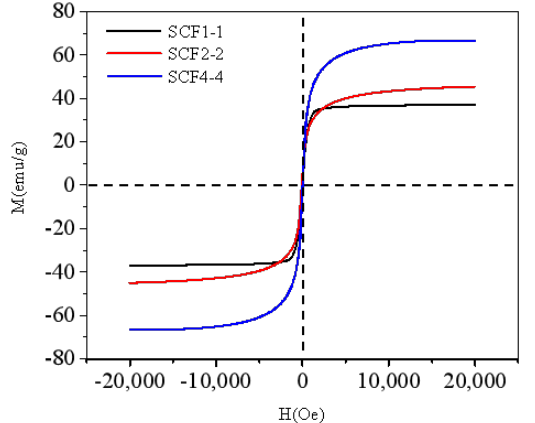
Figure 4. Room temperature field-dependent magnetization curves of SiC@C-Fe 3 O 4 hybrids. The complex permittivity (